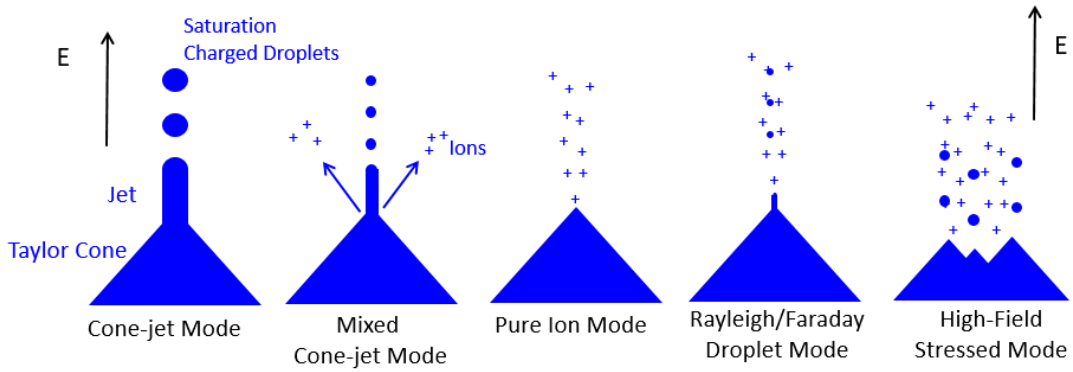
Figure 1. Summary of emission modes.